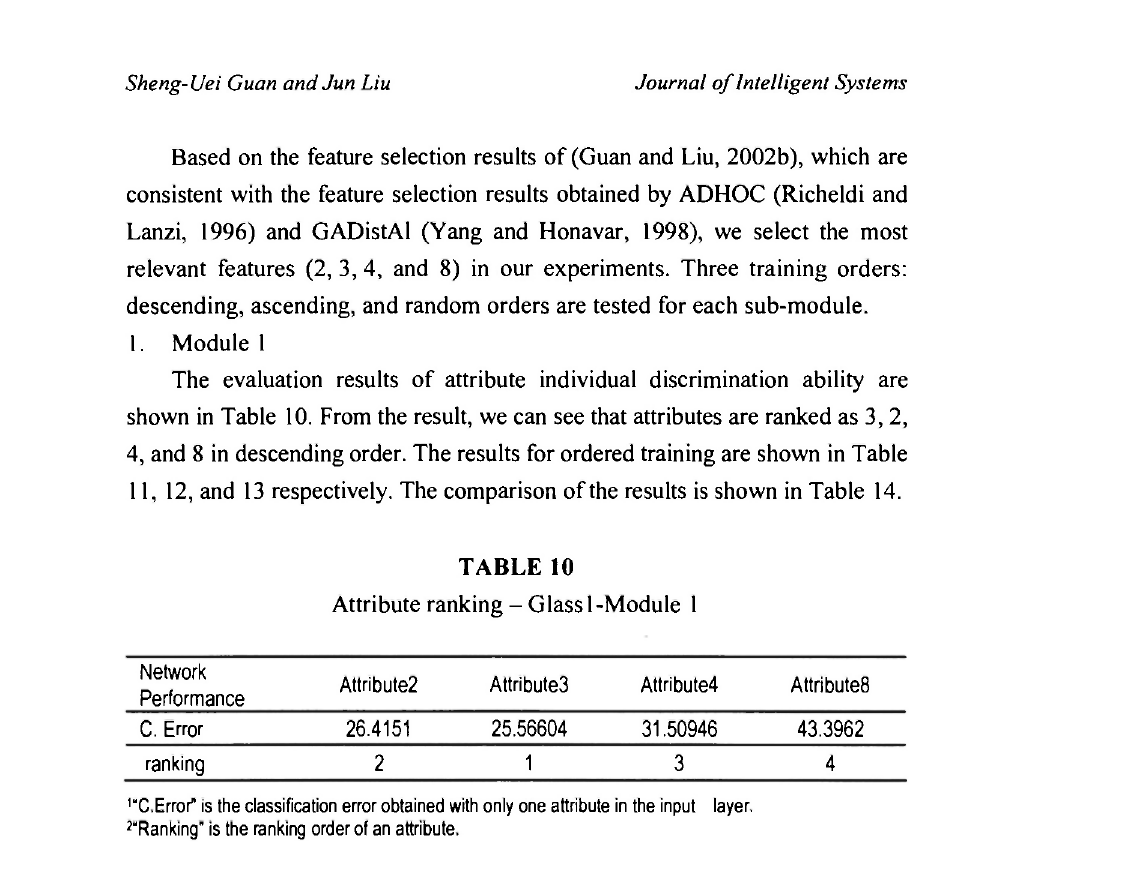
Attribute ranking - Glass 1-Module 1